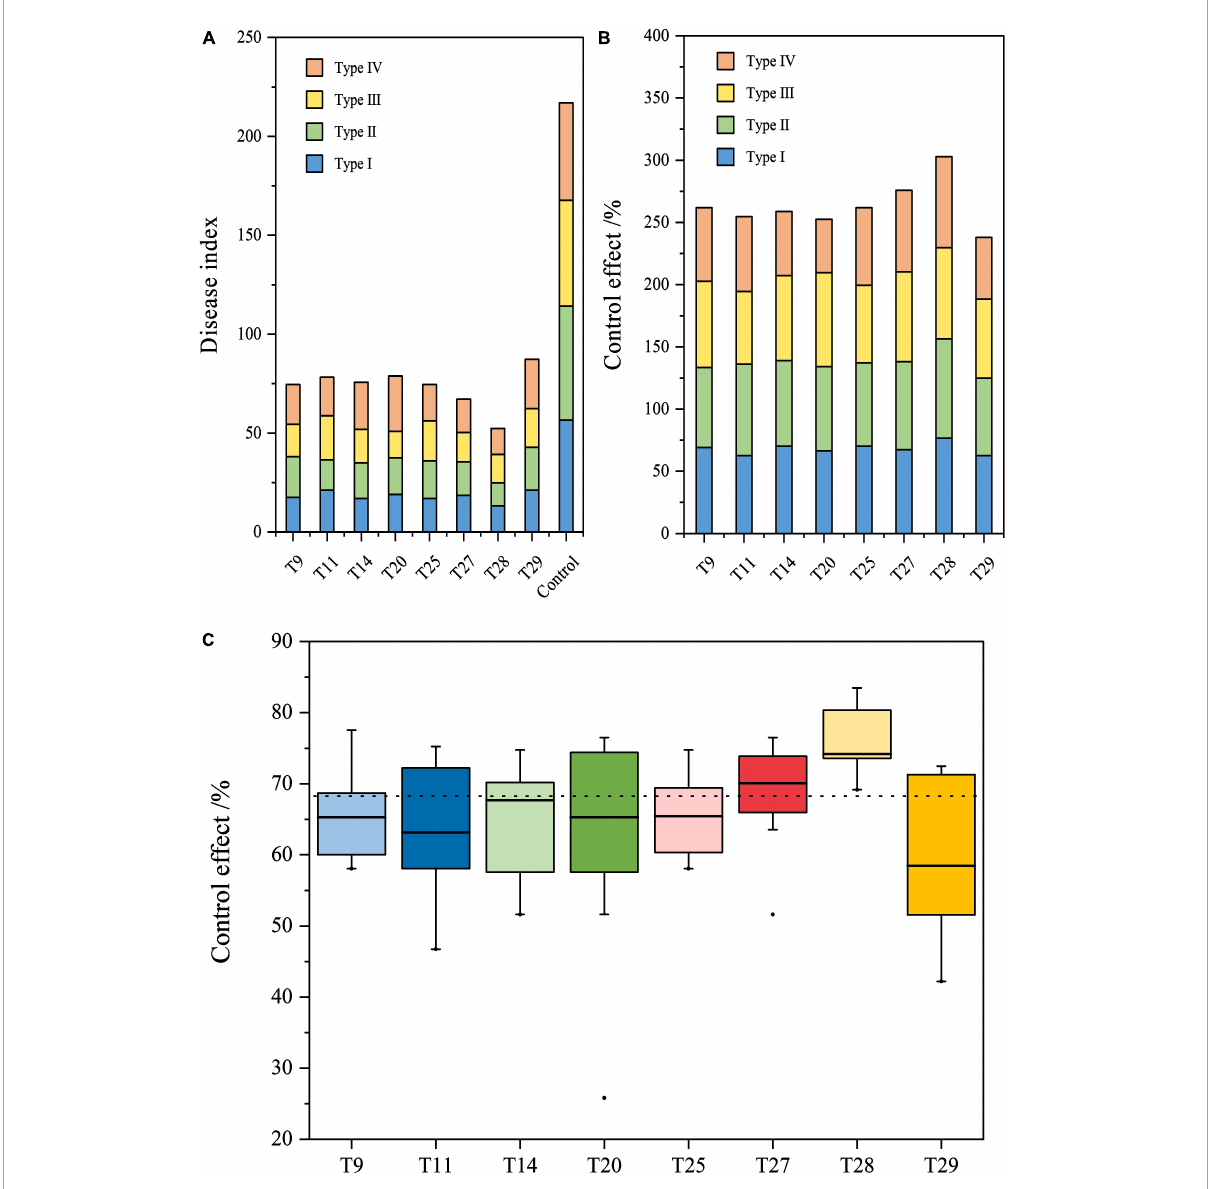
FIGURE4 Efficiency of biocontrol strain combinations against Fusarium wilt of banana in different types of soil. (A) Disease index banana seedlings treated with the eight combinations. (B) Control effect of the eight combinations against Fusarium wilt of banana. (C) Stability of the control effect on the eight combinations. Boxplots depict minimum and maximum values (whiskers), the interquartile range (box), outliers (dots), and median